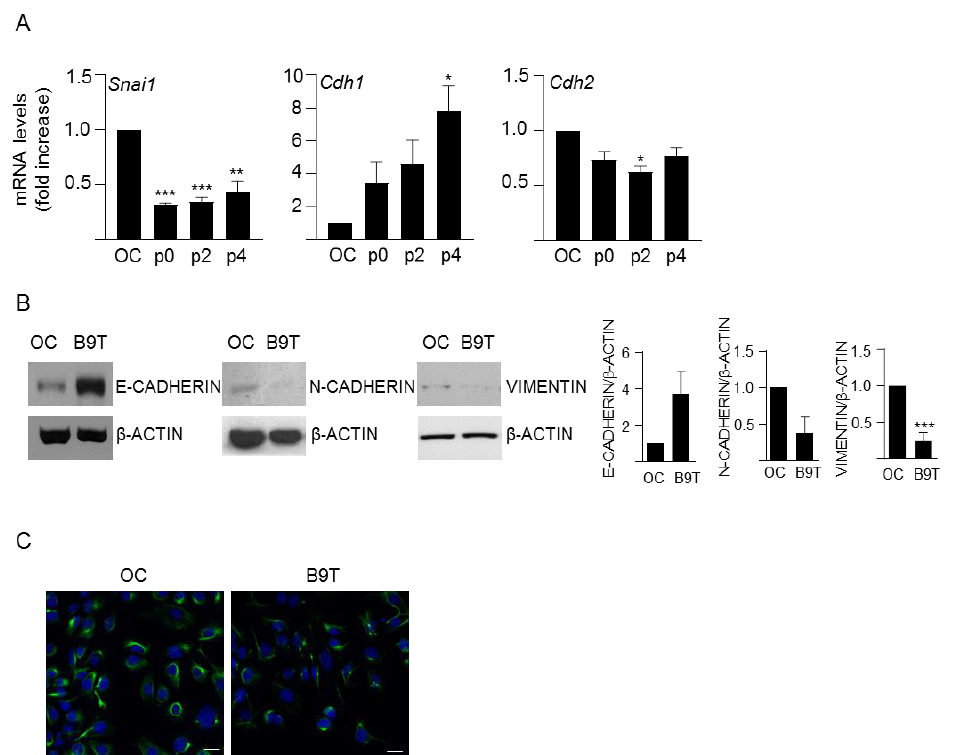
Figure 1. Analysis of EMT markers in B9T-OC. ( A ) RT-qPCR analysis for the expression of Snai1 , Cdh1 and Cdh2 in oval cells (OC) and B9T-OCs at different passages (passage 0, 2 and 4). Gusb was used for normalization. Data are expressed relative to oval cells (assigned an arbitrary value of 1) and are mean ± SEM of three independent experiments. * p < 0.05, ** p < 0.01 and *** p < 0.001 B9T-OC vs. OC. ( B ) Western blot analysis of E-CADHERIN, N-CADHERIN and VIMENTIN in oval cells (OC) and established B9T-OCs (B9T). A representative experiment (left panel) and a densitometric analysis (right panel) are shown. Data corresponding to optical density values relative to loading control are mean ± SEM of three independent experiments and are expressed relative to OC samples (assigned an arbitrary value of 1). ( C ) Oval cells (OC) and B9T-OCs (B9T) were fixed and stained with the VIMENTIN antibody and an Alexa Fluor 488 conjugated secondary antibody. Nuclei were counterstained with DAPI. Representative confocal microscopy images from two to three experiments are shown. Scale bar = 20 μm.